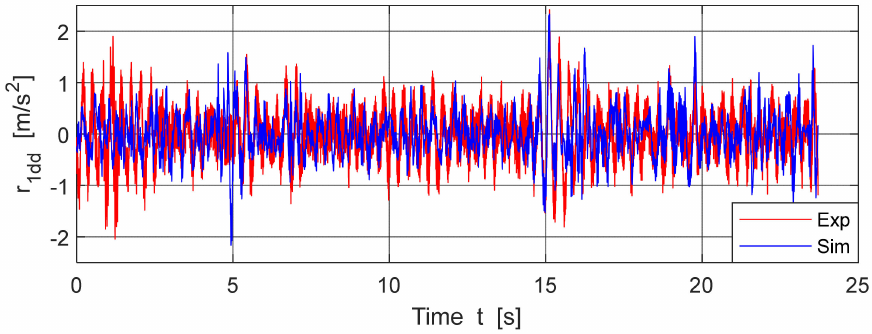
Figure 15. Acceleration in the center of gravity (CG) of vehicle sprung mass, V = 15.18